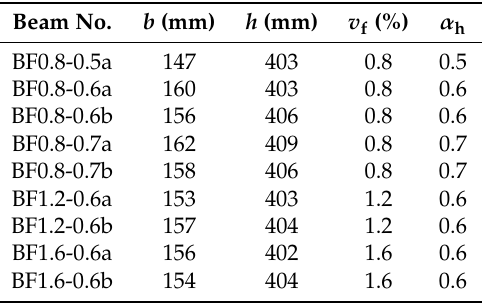
Figure 1. 3D view of reinforced SFRELC superposed beam (unit: mm). Table 2. Characteristics of test beams.